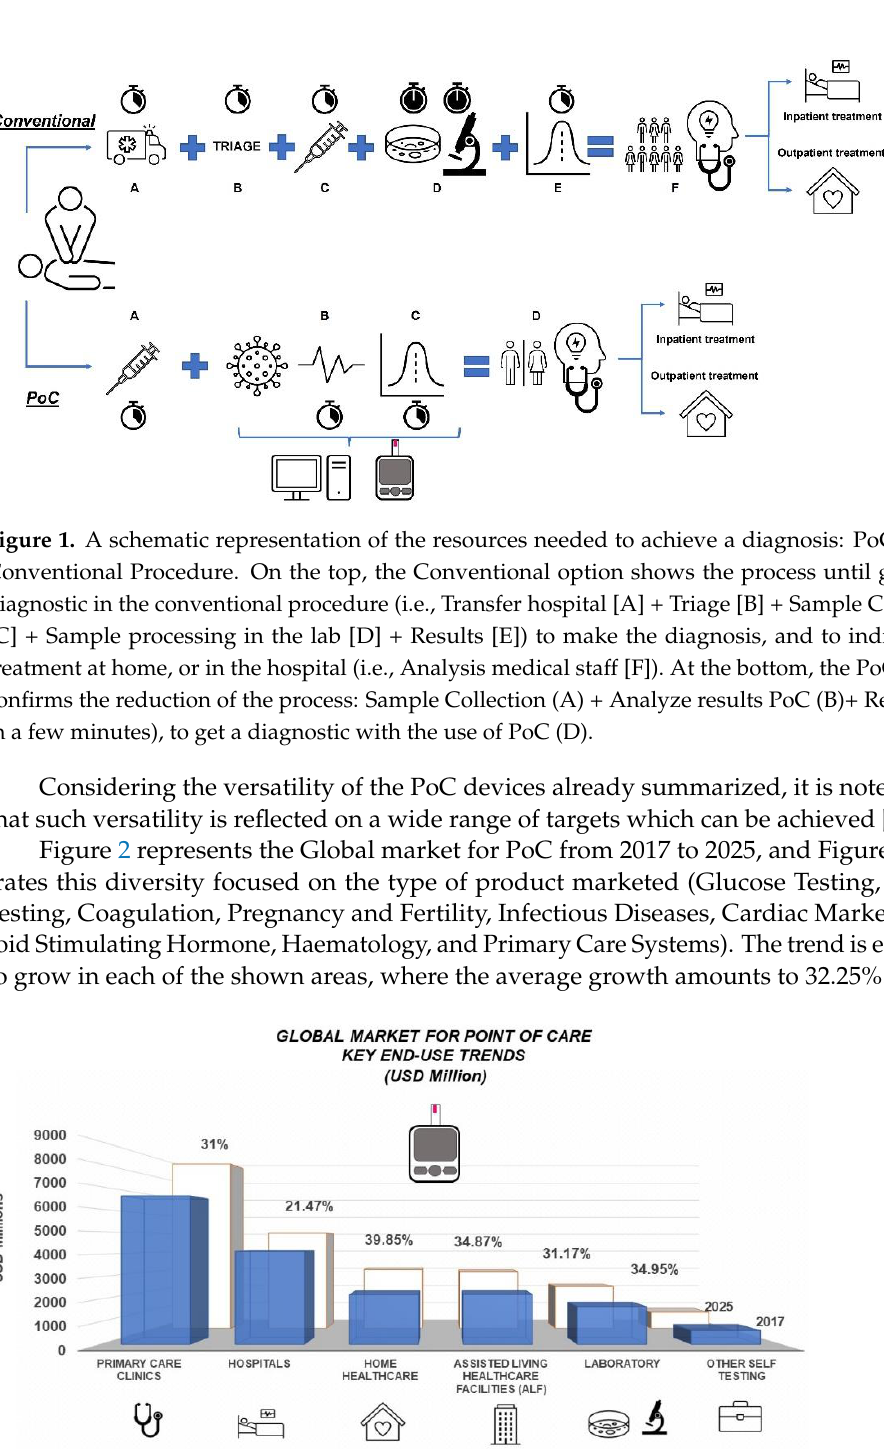
Figure 3. PoC Diagnostics Market and its segmentation attending to the target analysis and end-use: The market is classified in 14 different products according to pathology diagnostic, and in five kinds of products attending to the end use. (Data extracted from Grand View Research´s report [29]). The most attractive feature of PoC is that the detection can be performed on-site and in real-time, without the need for additional peripheral equipment, and the success of PoC diagnostics heavily depends on the continued development of alternative medical tech- nologies that are cost-effective, sensitive, and sufficiently accurate. As has been men- tioned, there are many advantages of the PoC devices; however, the challenge to translate researched technologies to the market for global health diseases is well known to both the scientific and business sectors. After the development of the laboratory prototype, several years are required to manufacture a product capable of entering the market because it requires a remarkable technical effort and significant investment to reach a truly market- able product in response to market needs.